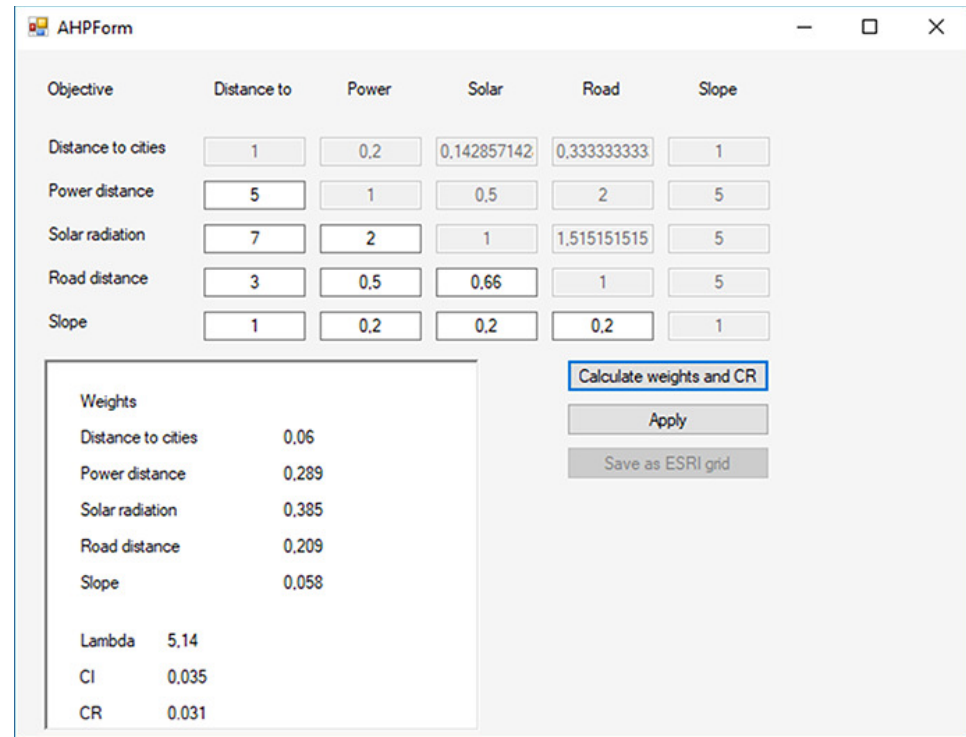
Figure 9. AHP window. The “Apply” button is enabled if the relative importance values for the criteria are consistent, i.e., if the consistency index CI ≤